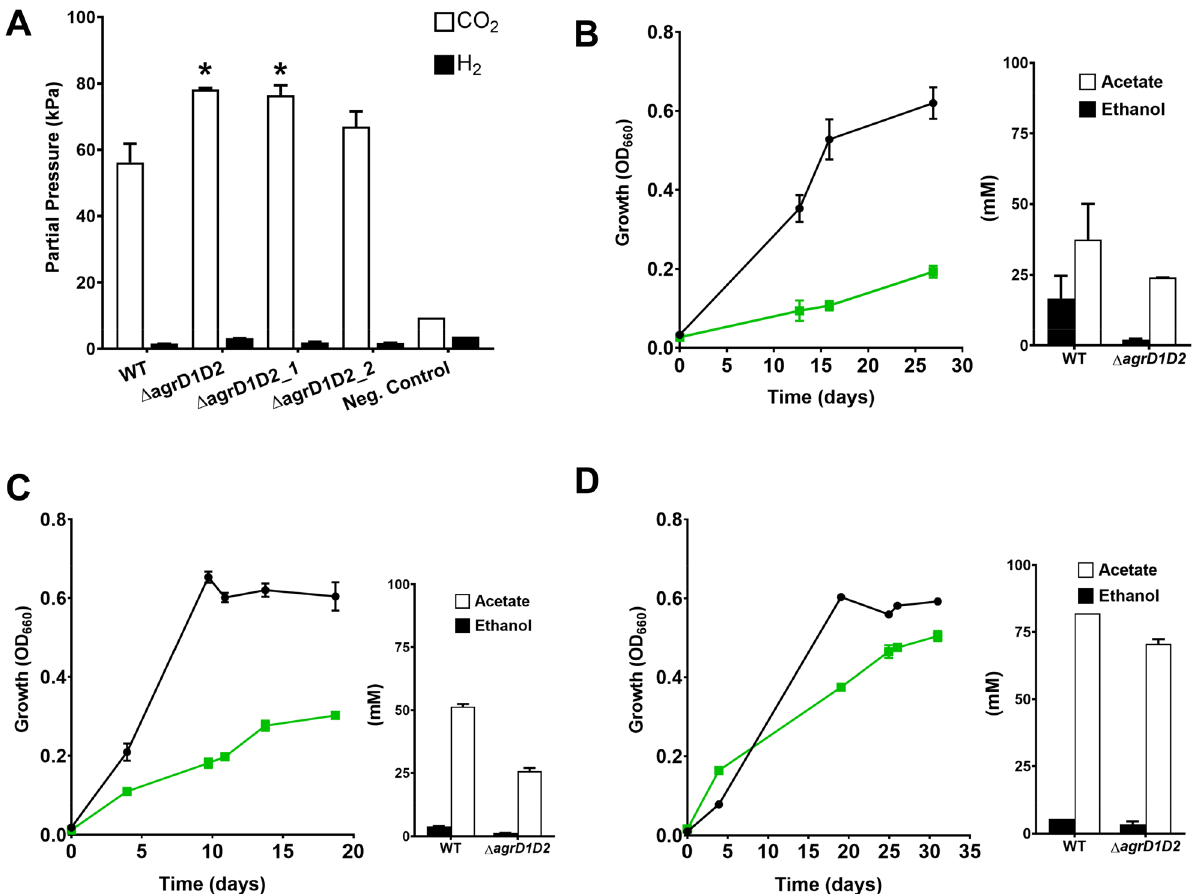
Figure 3. Diminished CO 2 re-assimilation and autotrophic behaviour of Δ agrD1D2 mutants represented through; ( A ) Comparison of CO 2 partial pressures of fructose-grown cultures after 200 h in three independent Δ agrD1D2 mutants against the WT (n = 4), Δ agrD1D2 (n = 3), Δ agrD1D2_1 (n = 4), Δ agrD1D2_2 (n = 4) and negative control (n = 1); the negative control represented WT cultures without fructose addition. ( B – D ) Adaptive growth on 200 kPa CO with fermentation product profiles of WT (Black circles) and Δ agrD1D2 (Green squares) that represent first ( A ), second ( B ), and third ( C ) subcultures of WT (n = 2) and Δ agrD1D2 (n = 2) cultures, growing over a period of 29, 19 and 31 days respectively. Main metabolic products, acetate and ethanol were measured at the end of each fermentation. All error bars indicate standard error of the mean, P values equate to: * ≤ 0.05 of statistical difference to the